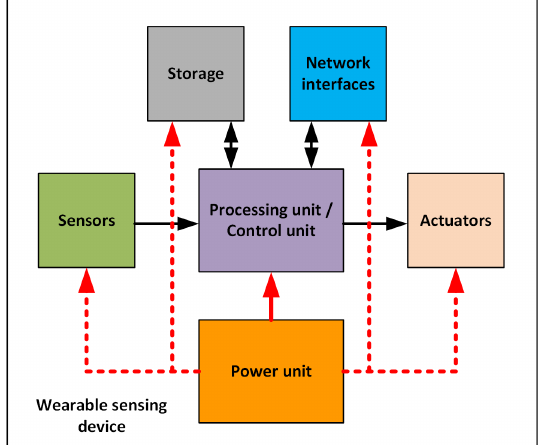
Figure 5. Typical components of a wearable sensing device. The red dotted line indicates possible connection.